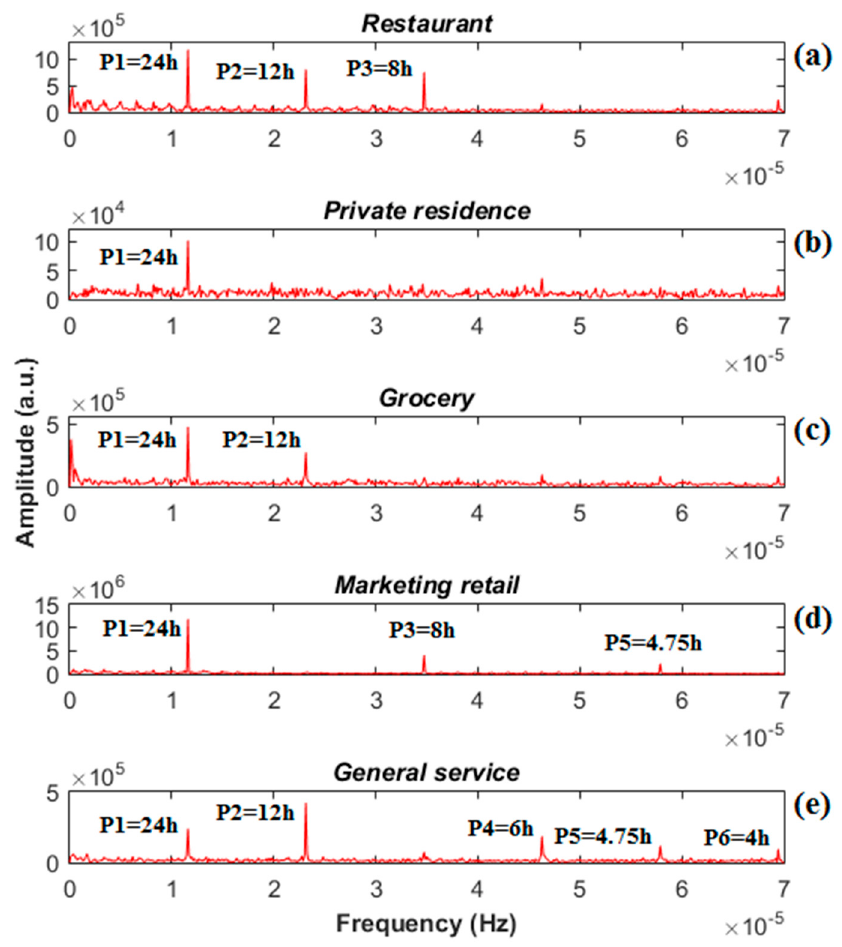
Figure 4. Fourier spectrum of the reactive power with the peaks highlighted ( a ) restaurant; ( b ) private residence; ( c ) grocery; ( d ) marketing retail establishment; ( e ) general service.